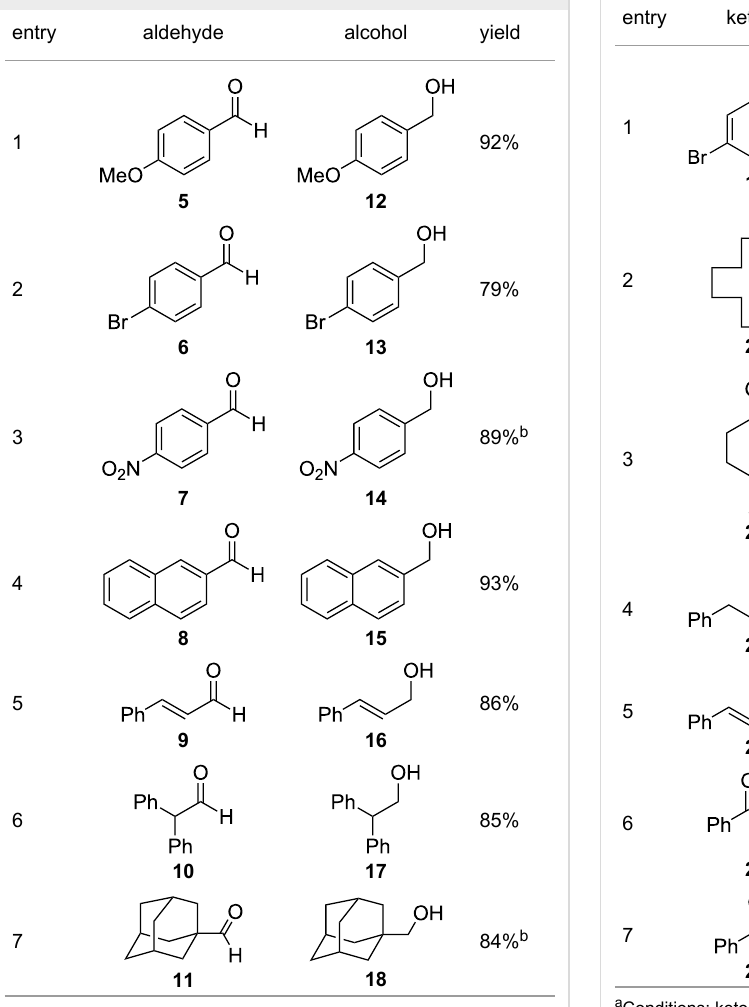
Table 2: Reductions of ketones by diMe-Imd-BH 3 ( 1 ) and acetic acid. a entry ketone alcohol